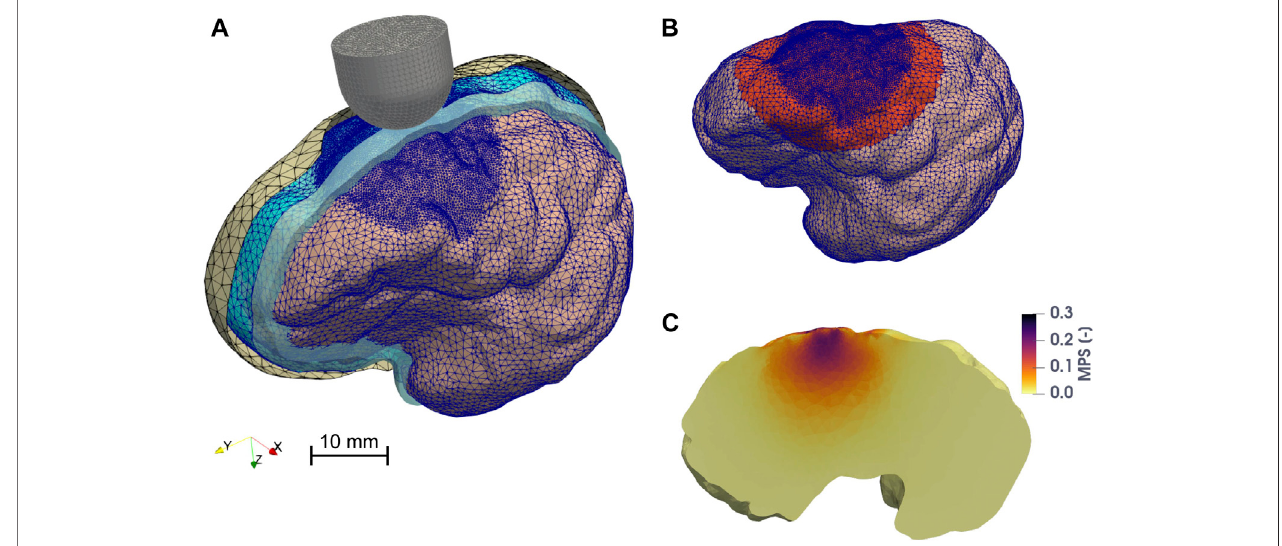
FIGURE2| FiniteelementmodeloftheporcinebrainundergoingCCI. (A) Overviewoftheassemblyofthemodel.Theskull,theDAM,andtheCSFarerepresented with parallel sectioned views. The mesh of the discrete rigid parts (skull (cid:1) yellow and probe (cid:1) gray) is depicted in black, while the mesh of the deformable bodies (brain hemisphere (cid:1) pink, DAM (cid:1) cyan), which is fi ner in the vicinity of the impact point, is colored in blue. The cavity fi lled by CSF is represented in light blue. (B) The zone highlightedinred representstheelements ofthebrain(in theundeformed con fi guration) belongingtotheregionofinterest(ROI), considered forthecomputationof the 95th percentile of MPS, MPSR, MPSXSR, and MSS. (C) Maximum principal strain distribution on a parasagittal cross section of the brain when the probe reaches maximum depth. The image is taken from one of the FE CCI simulations used to train the ANN. The input parameters were: a hemispherical probe (diameter (cid:1) 15 mm), velocity of indentation (cid:1) 1.8 m/s, depth of indentation (cid:1) 5.4 mm, angle of inclination (cid:1) 3 ° , DAM-probe friction coef fi cient (cid:1) 0.24, and thickness of the meninges (cid:1) 0.655 mm. The highest MPS values are concentrated around the impact point, within the